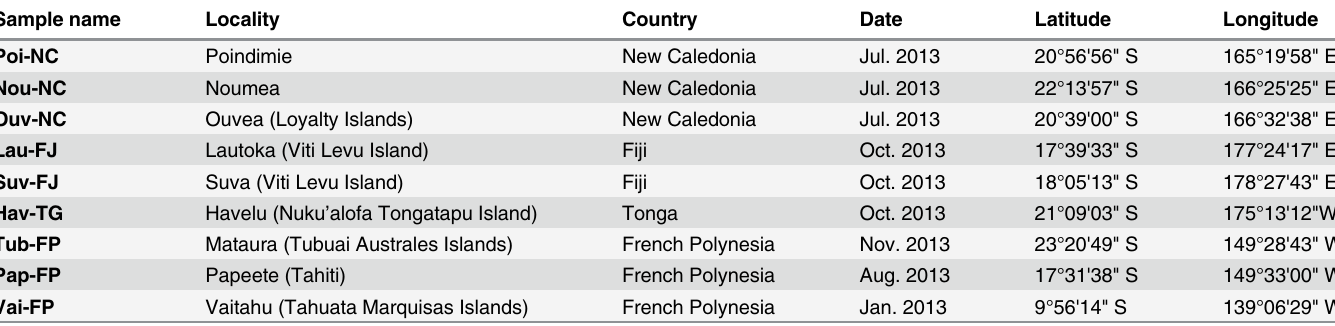
Table 1. Ae aegypti sampling sites: coordinates and date in Pacific islands,